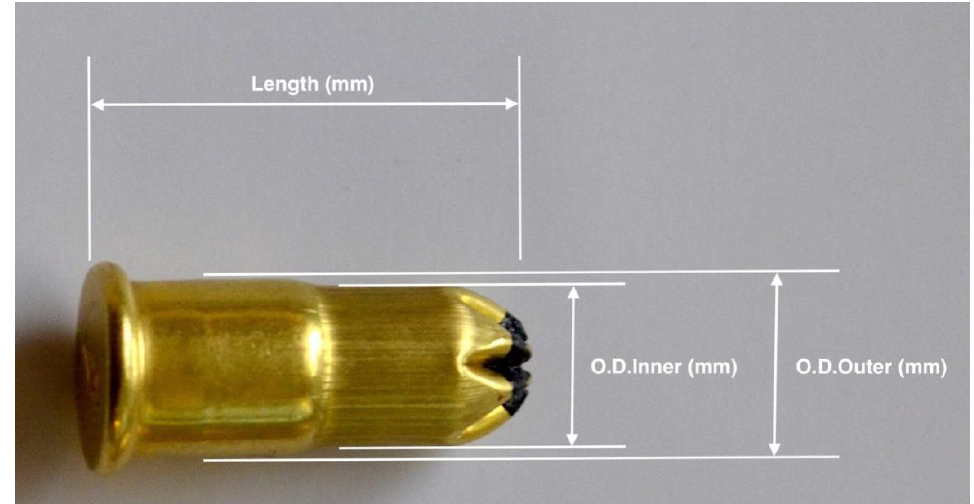
Figure 1. Dimension of cartridges — assessment points recorded for each cartridge.